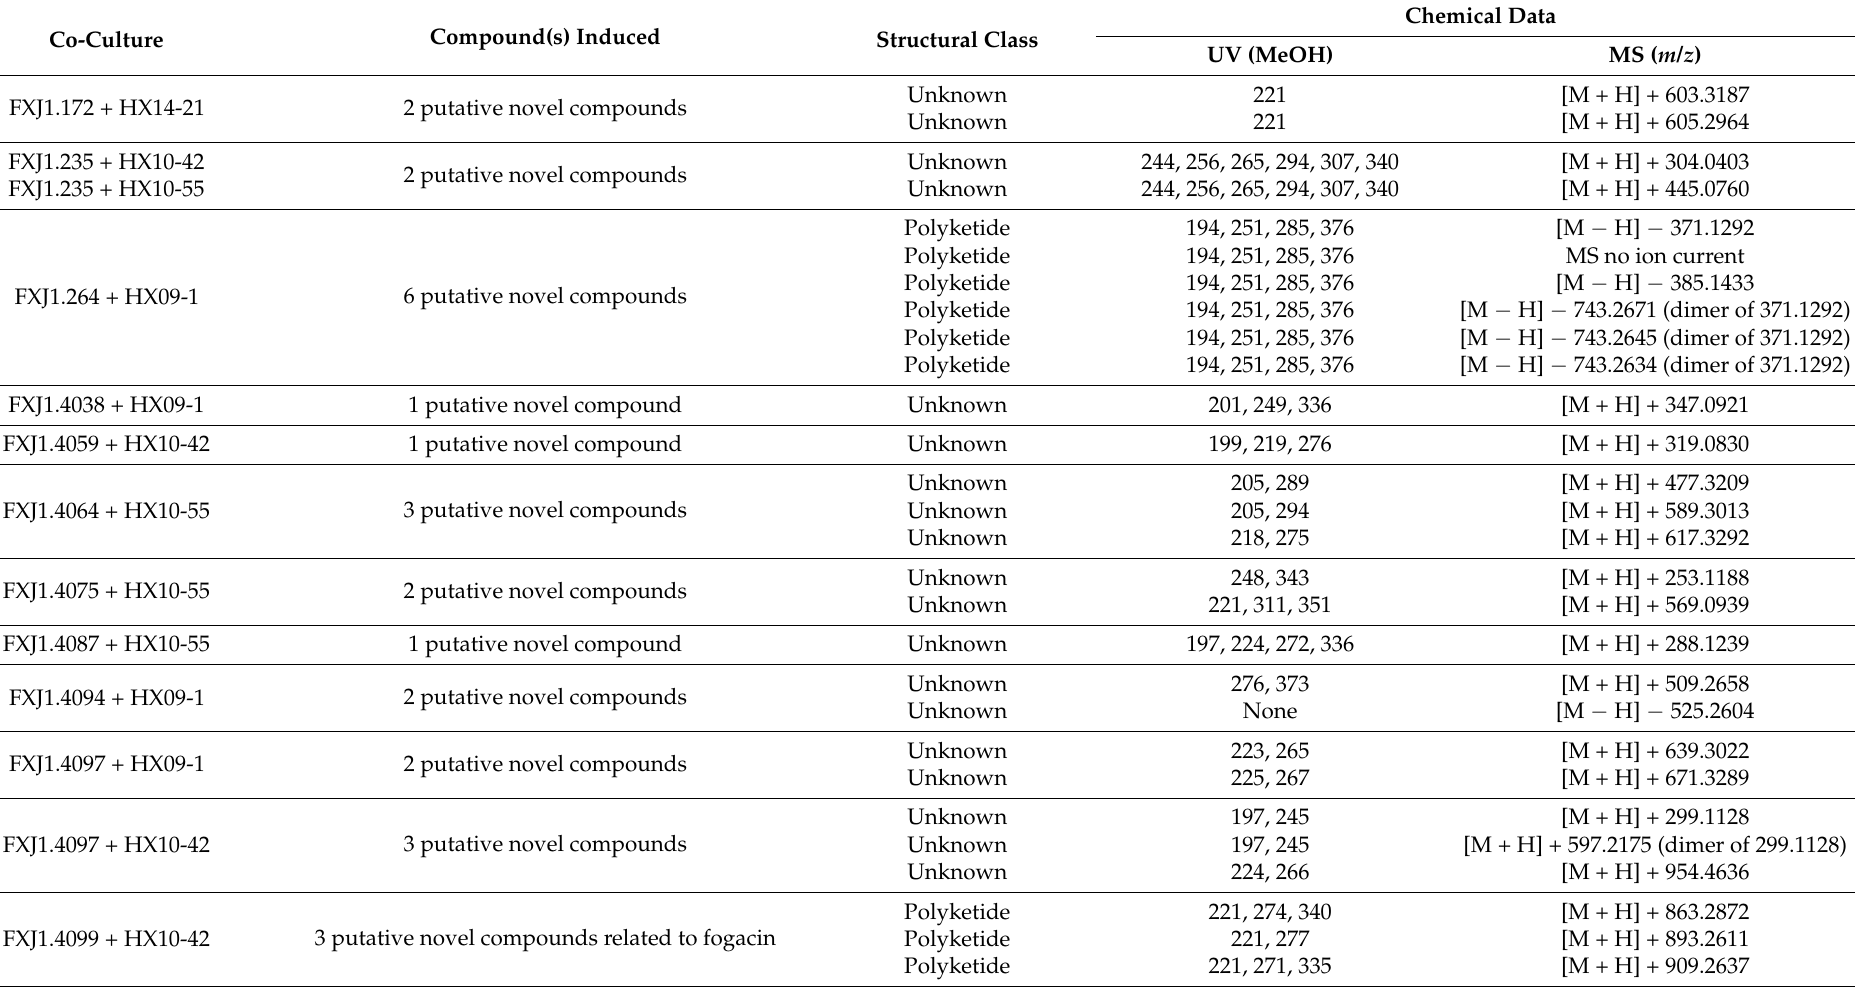
Table 3. Putative novel products from co-cultures of the streptomycetes and